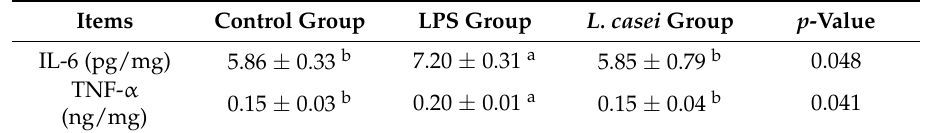
Table 3. Effects of dietary supplementation with L. casei on the concentrations of IL-6 and TNF- α in the piglet